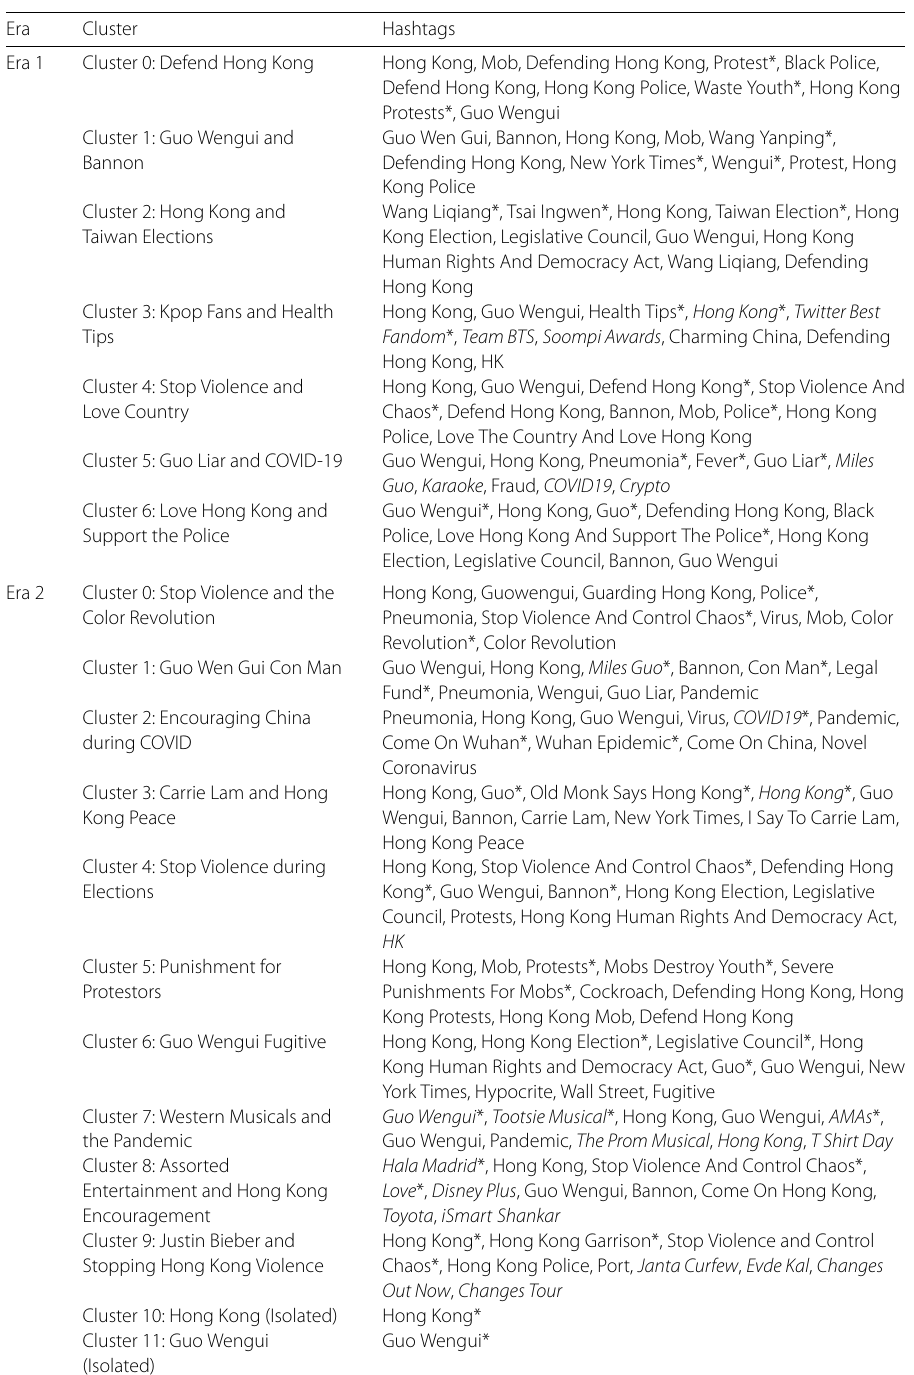
Table 6 Summary of hashtags used by MVMC clusters of Chinese state-sponsored accounts. Hashtags marked with a (*) are the hashtags with the top 3 highest tf-idf scores. Italics indicate hashtags did not undergo translation; otherwise they were in Chinese